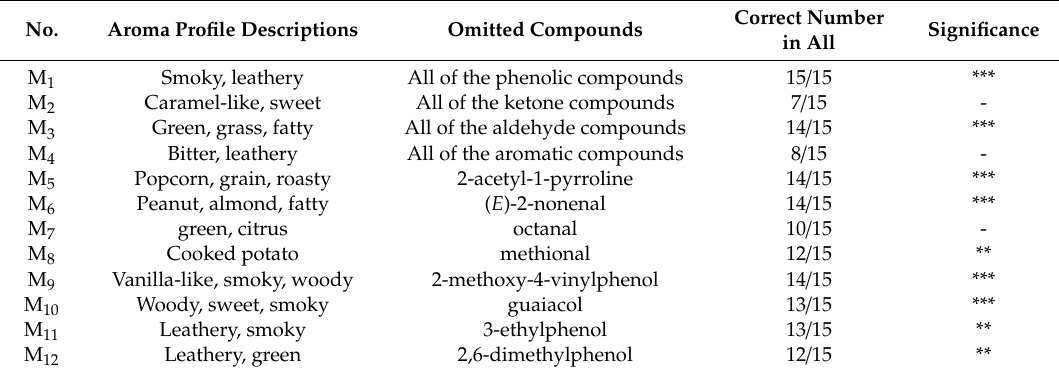
Table 4. Results of the omission tests.